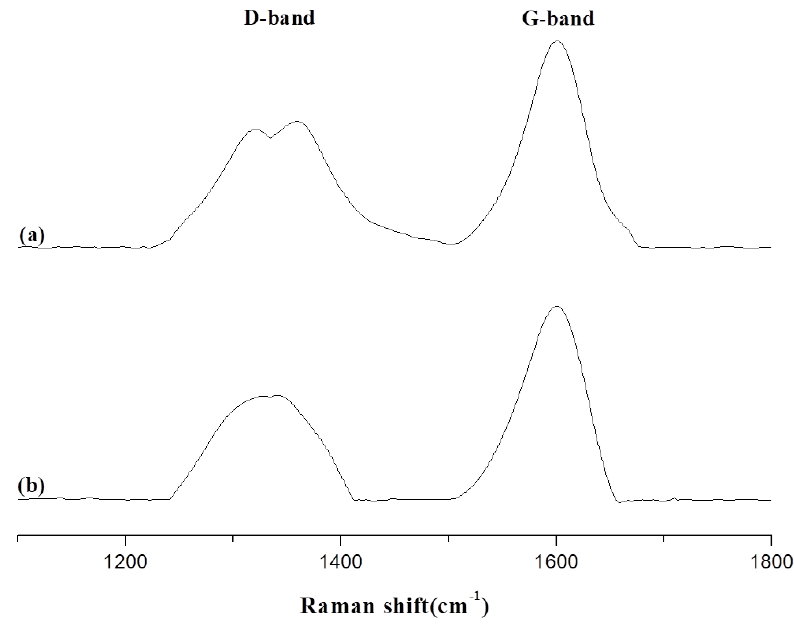
Figure 6. Raman spectra of biochar products from Epoxy/Bagasse@TGIC@DOPO IPN 5% at 800 ◦ C ( a ) 1 min, ( b ) 5 min. Table 2. D/G for the Raman shift from Epoxy/Bagasse@TGIC@DOPO IPN composites biochar.